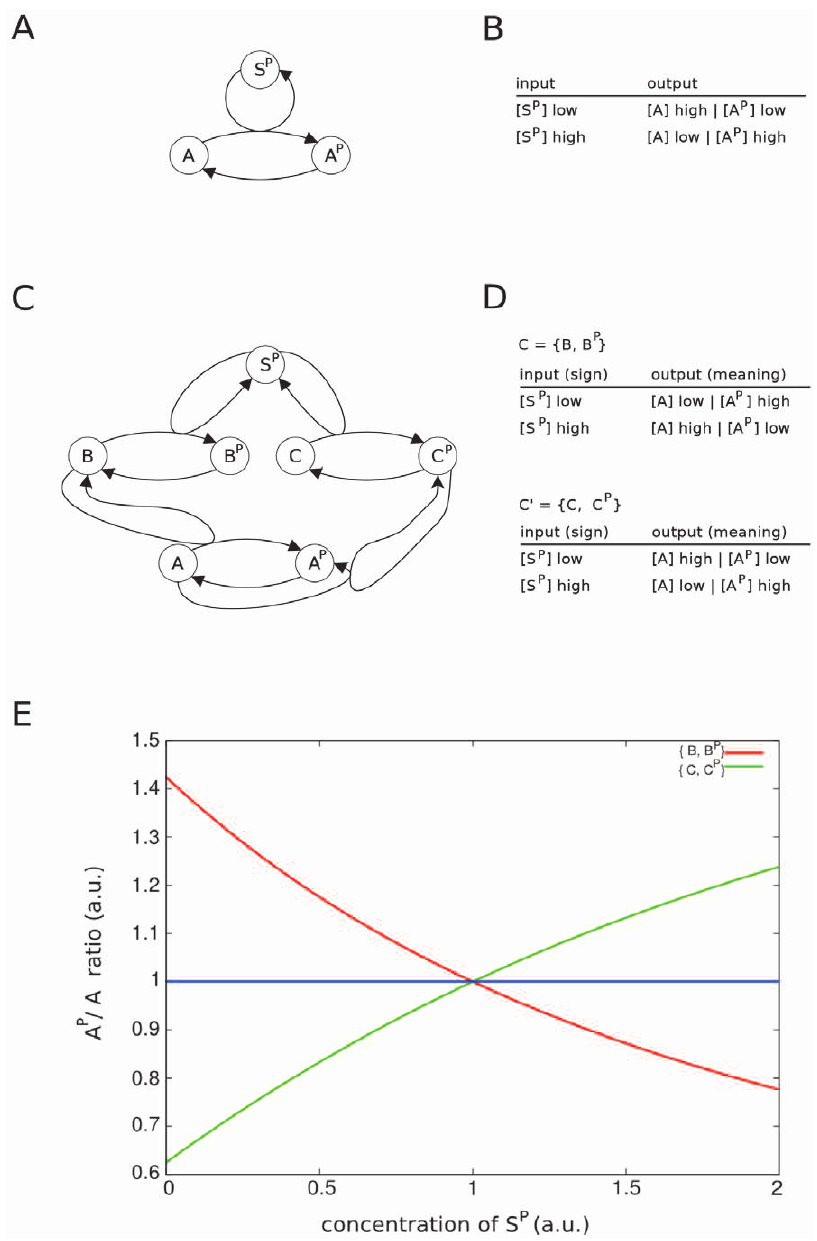
Figure 4. Reaction networks describing phosphorylation motifs. Molecular species in these networks represent kinases that may be activated or inactivated by phosphorylation. Activated and non-activated forms of a kinase are modeled as different species (e.g. species A and A P ). Panel A: Reaction network of a simple phosphorylation motif, which can realize a molecular mapping, but not a molecular code. Panel B: Molecular mappings that can be realized by the reaction network from panel A. These mappings do not constitute a molecular code. Panel C: M ore complex reaction network that can realize molecular codes. Panel D: The two binary molecular codes (i.e., one code pair) are realized by either one of the two molecular contexts f B , B P g or f C , C P g . In contrast to the other described molecular codes (e.g. the genetic code), here, the code is not only specified by the species also, but also by the species’ concentrations. Panel E : Simulation of the second network (panel C) showing the ½ A P (cid:2) = ½ A (cid:2) ratio over ½ S P (cid:2) for the two different contexts. The red line shows the system’s behavior for the context f B , B P g , while the green line shows the system’s behavior for the alternative context f C , C P g over varying initial concentrations for S P . The blue line indicates the (here arbitrary) threshold to separate high and low